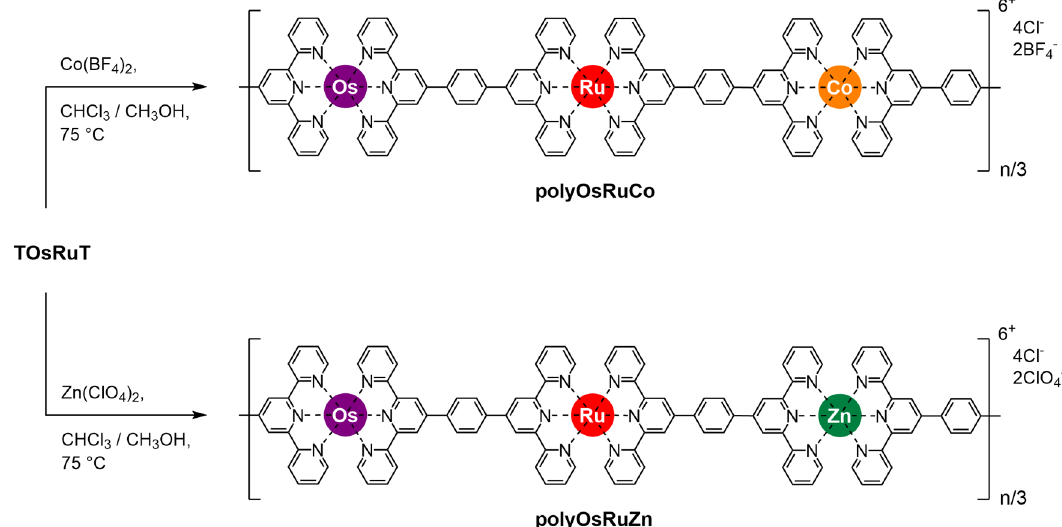
Fig. 5 Synthesis and chemical structure of polyOsRuCo and polyOsRuZn. Synthetic route to polyOsRuCo and polyOsRuZn from